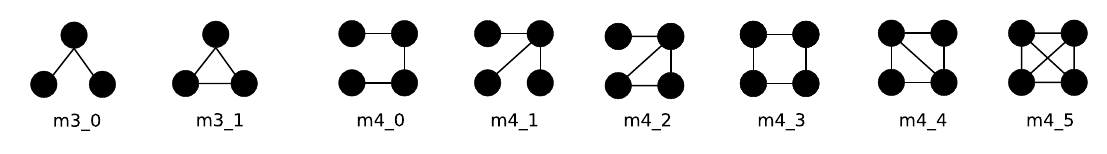
Figure 1. 3-node motifs and 4-node motifs.